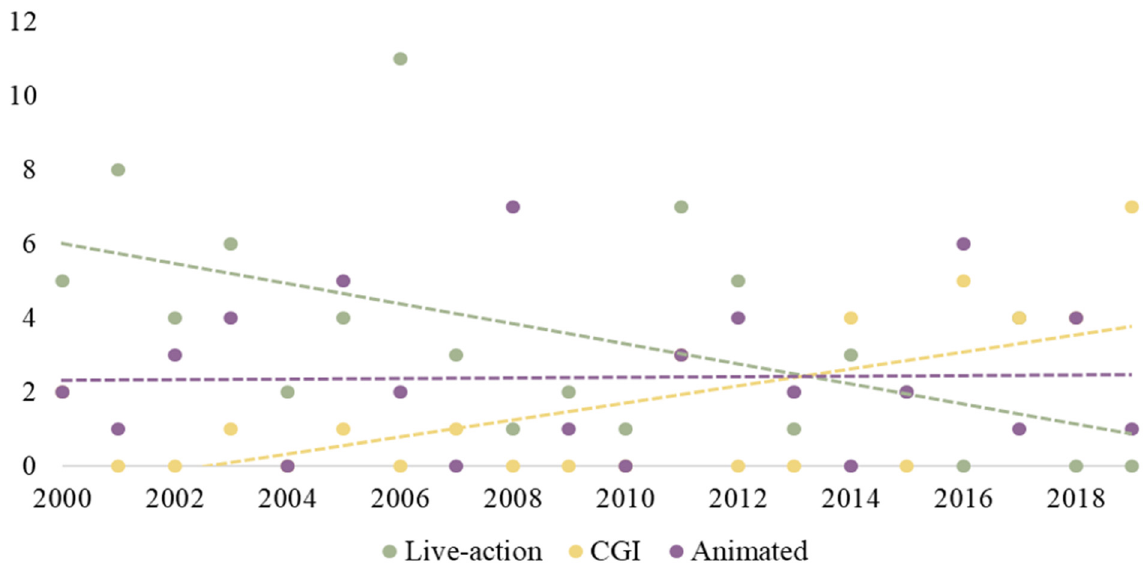
Figure 2. Annual frequency of medium use. Each point represents the number of recorded primate occurrences in each medium, per year. Dashed lines represent the average trends overtime for medium depiction.